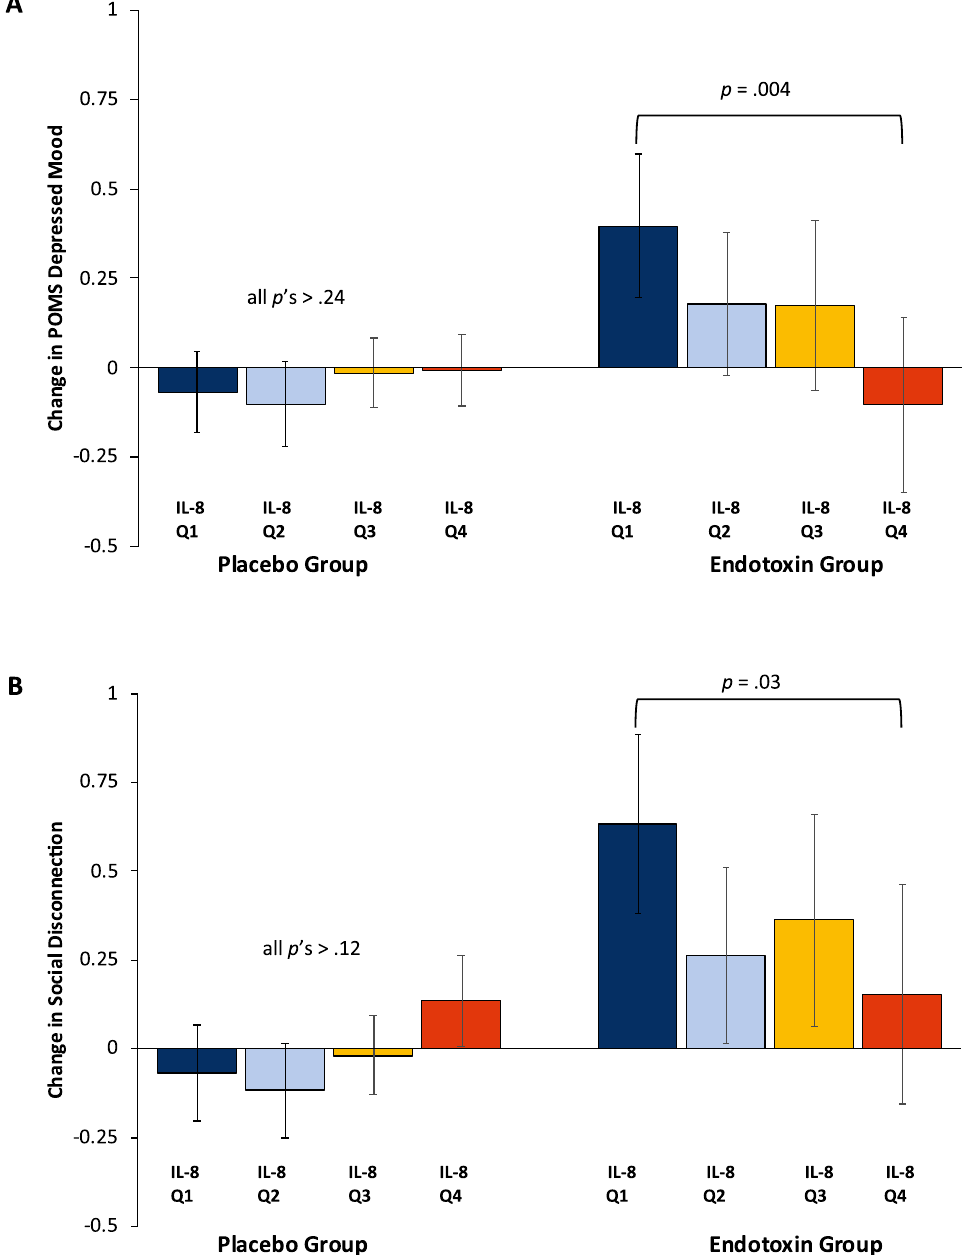
Figure 2. Predictive means for change in behavioral measures by baseline IL-8 quartile Within the endotoxin group, the upper IL-8 quartile (Q4) showed lower depressive mood response as compared to the lowest IL-8 endotoxin quartile (Q1) ( p = .004) and the lower three IL-8 quartiles combined (Q4 to Q1-3, p = .02), but not individually (Q4 to Q2 , p = .08; Q4 to Q3, p = .12). ( A ). The Q4 endotoxin quartile also showed lower social disconnection response as compared to Q1 ( p = .03) but not all three combined (Q4 to Q1-Q3, p = .15) or individually (Q4 to Q2, p = .59; Q4 to Q3, p = .35). ( B ). Error bars are 95% Confidence